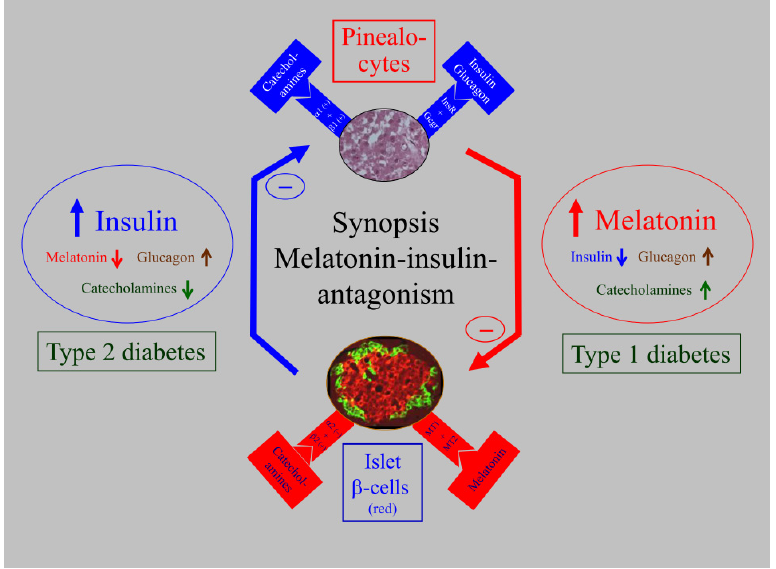
Figure 2. Synoptic presentation of the insulin–melatonin antagonism in relation to the importance of melatonin for type 1 and type 2 diabetes, including interactions with glucagon and catecholamines. At a relatively early stage of type 2 diabetes (left side), insulin secretion is increased while melatonin synthesis is decreased. These reactions were observed in type 2 diabetic Goto Kakizaki (GK) rats and humans. In contrast, under type 1 diabetic conditions (right side), insulin was greatly reduced and, subsequently, melatonin was significantly increased. These reactions were observed in streptozotocin (STZ)-treated Wistar (WR) rats, as well as in LEW.1AR1- iddm rats, a spontaneous animal model of human type 1 diabetes mellitus. Thus, the influence of insulin on the pinealocytes is mediated by insulin receptors in the pineal gland (upper panel), and the influence of melatonin on the pancreatic β -cells is mediated by the MT1 and MT2 melatonin receptors (lower panel). Much more conclusive, however, is the well-known insulin-catecholamine relationship, which may be a key to understanding the insulin-melatonin antagonism. The increase of catecholamines stimulates adrenoceptor β 1 and, consequently, the cAMP cascade, while adrenoceptor α 1 activates the IP3 cascade in the pineal gland; together they stimulate melatonin synthesis and secretion (upper panel). Catecholamines (in contrast to acetylcholine), on the other hand, have an inhibitory effect on the insulin secretion (lower panel). To support this, the GK rat model of type 2 diabetes shows diminished plasma catecholamines (left side), whereas the rat models of type 1 diabetes (STZ and LEW.1AR1- iddm ) exhibit increased catecholamines (right side). This supports the conviction that type 1 diabetes is associated with stress and enhanced melatonin